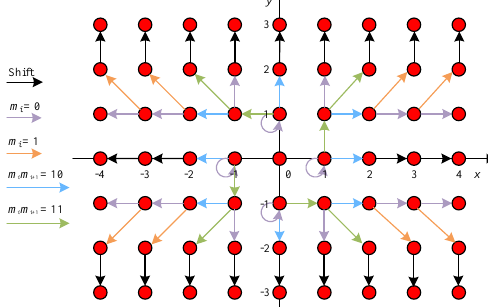
Figure 5. The proposed 2D HS without using the ( 0,0 ) coefficient